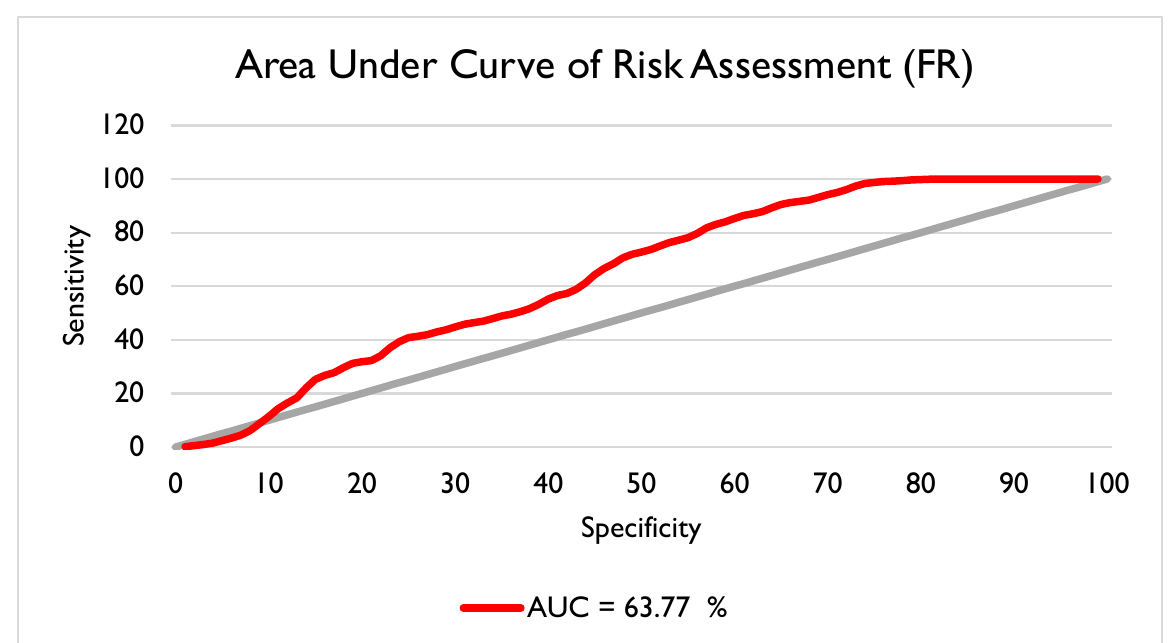
Figure 17. Area Under the Curve conducted for risk assessment created from